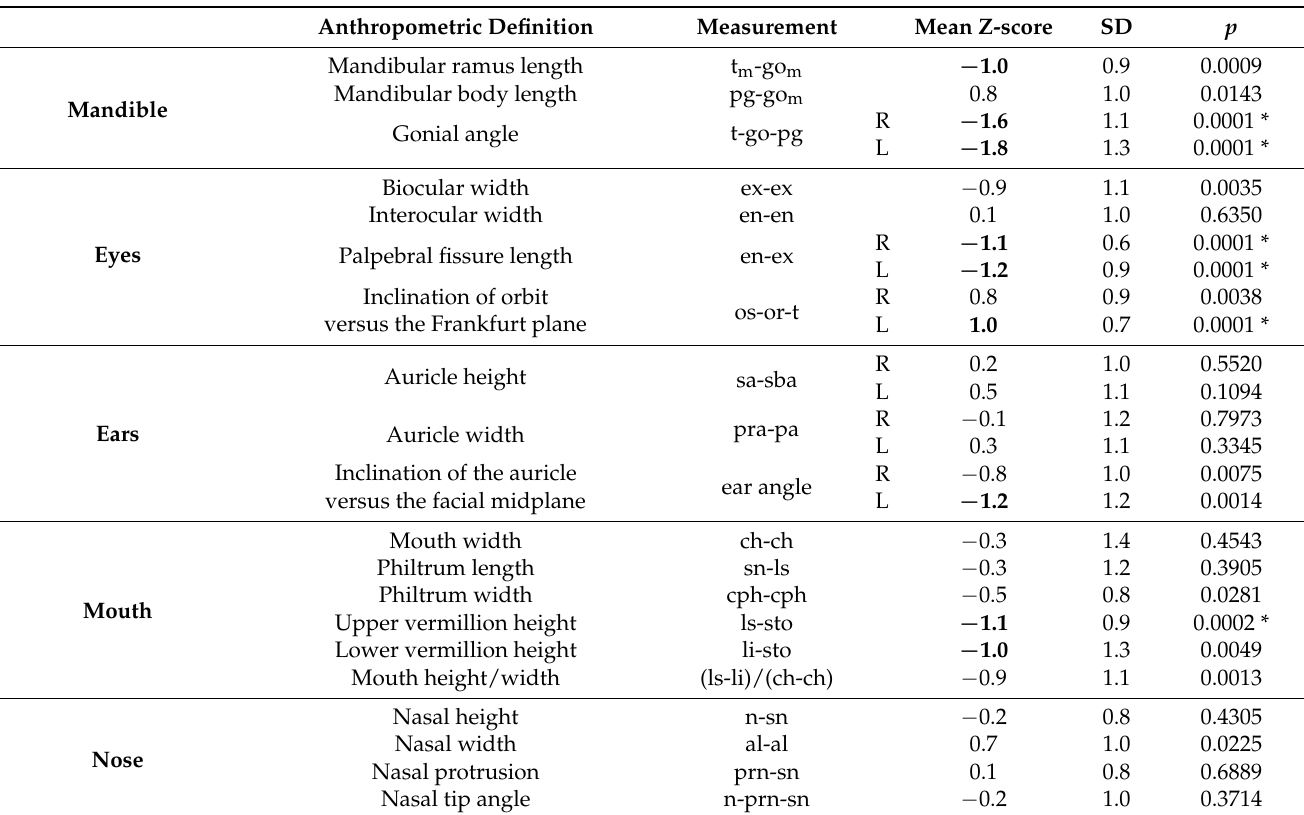
Table 3. 3D anthropometric measurements describing parts of the face in subjects with PWS as compared to healthy